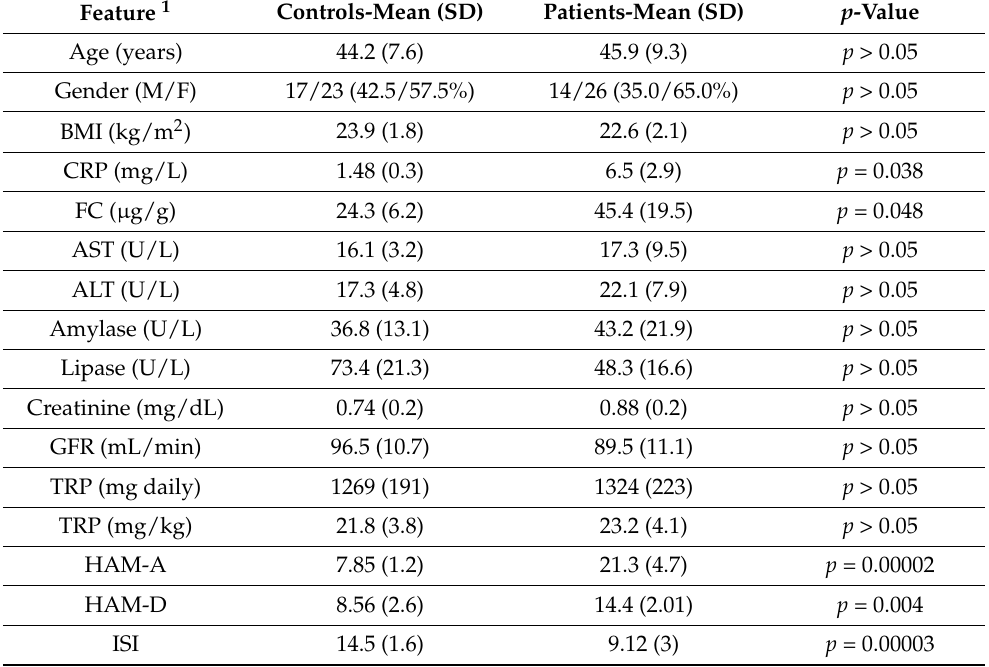
Table 1. Characteristics of the healthy subjects (controls, n = 40) and patients with diarrhea predom- inant irritable bowel syndrome (IBS-D, n = 40) included in the study, and the selected laboratory baseline data, tryptophan intake, and severity symptoms; mean (SD). Feature 1 Controls-Mean (SD) Patients-Mean (SD) p -Value Age (years) 44.2 (7.6) 45.9 (9.3) p >